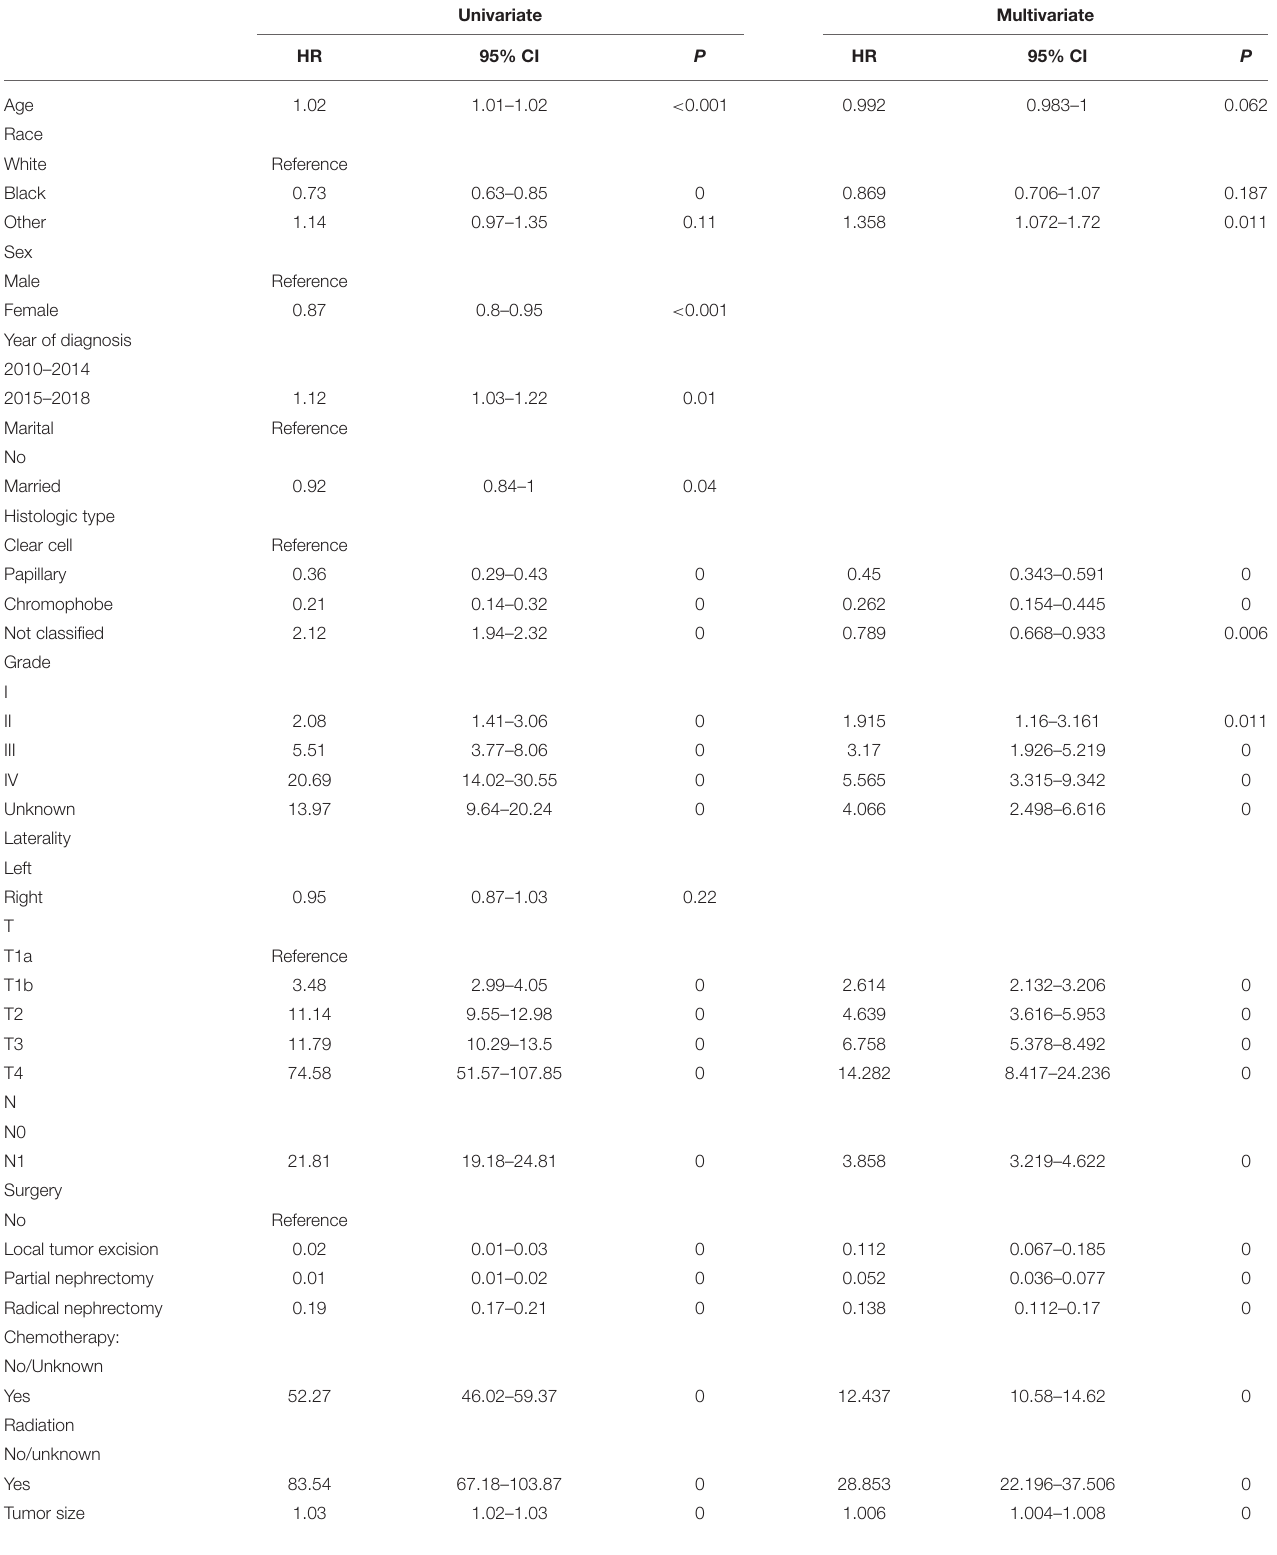
TABLE 2 | Univariate and multivariate analyses of CSS in training set. Univariate